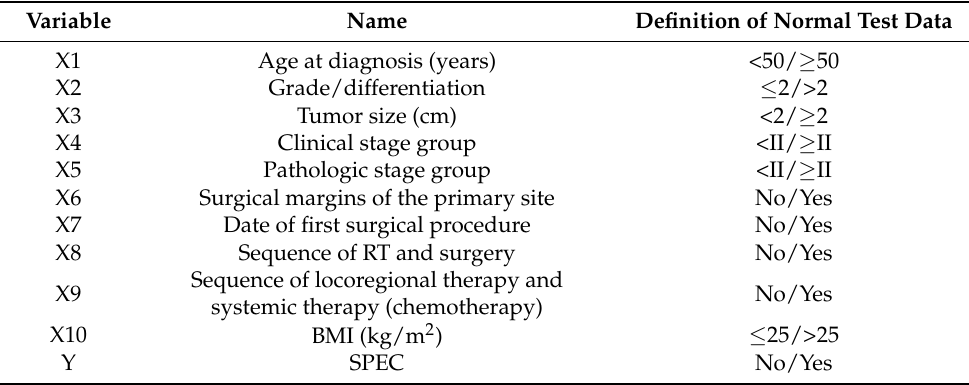
Table 3. Important variables and coding in this study.